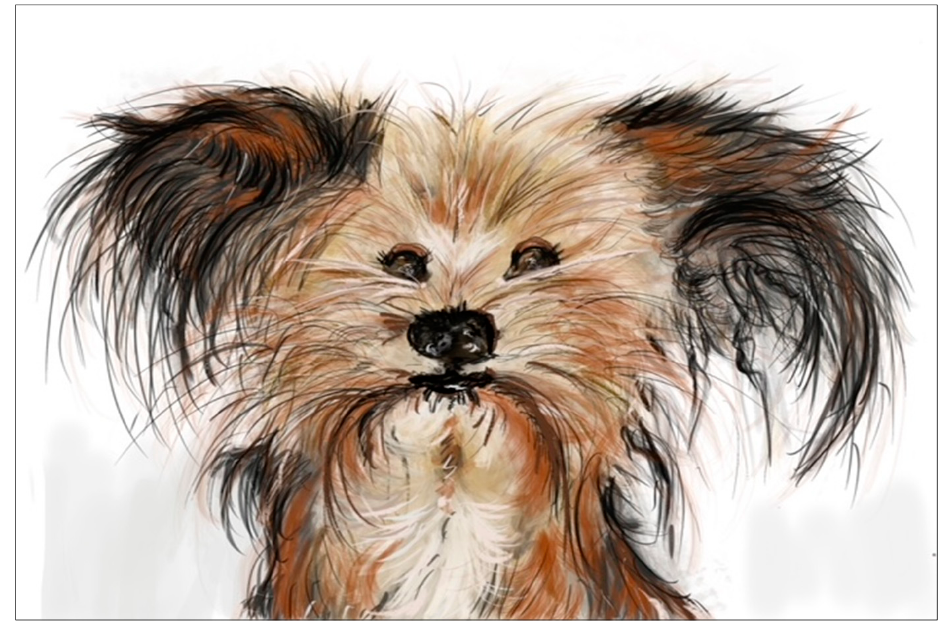
Figure 4. Mary ‘becoming-with dog’ by co-opting ‘Andrew’ in her social class nomadic war(fare)machine (NWM).